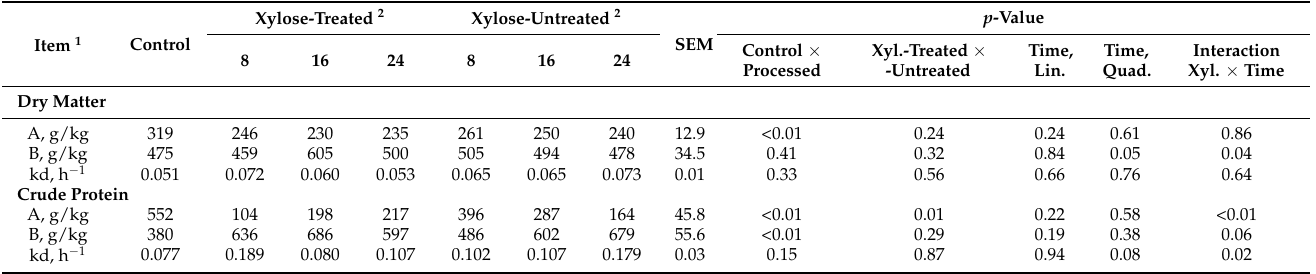
Table 4. Effects of autoclave and xylose inclusion on rumen degradation parameters of cotton- seed